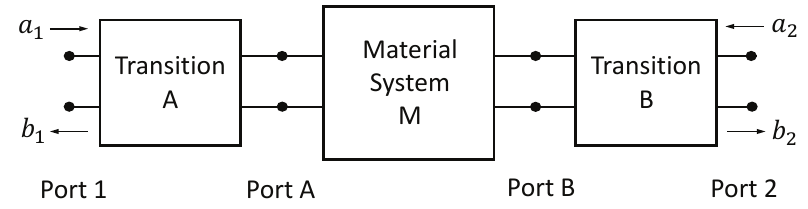
Figure 3. Two-port model of the triaxial system, showing coaxial transitions A and